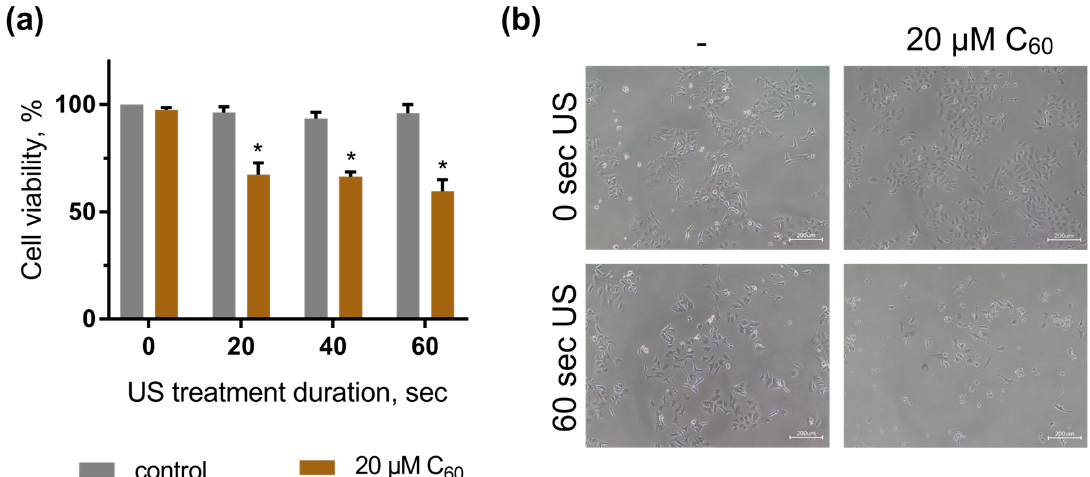
Figure 4. Viability of HeLa cells, incubated in the presence of 20 µM C 60 and treated with 1 MHz ultrasound (US): ( a )—MTT assay, *— p ≤ 0.01 in comparison with the viability of cells, treated with the respective duration of US; ( b )—Phase contrast microscopy images of HeLa cells, incubated in the presence of 20 µM C 60 and treated with 60-s ultrasound, scale bar 200 µm.